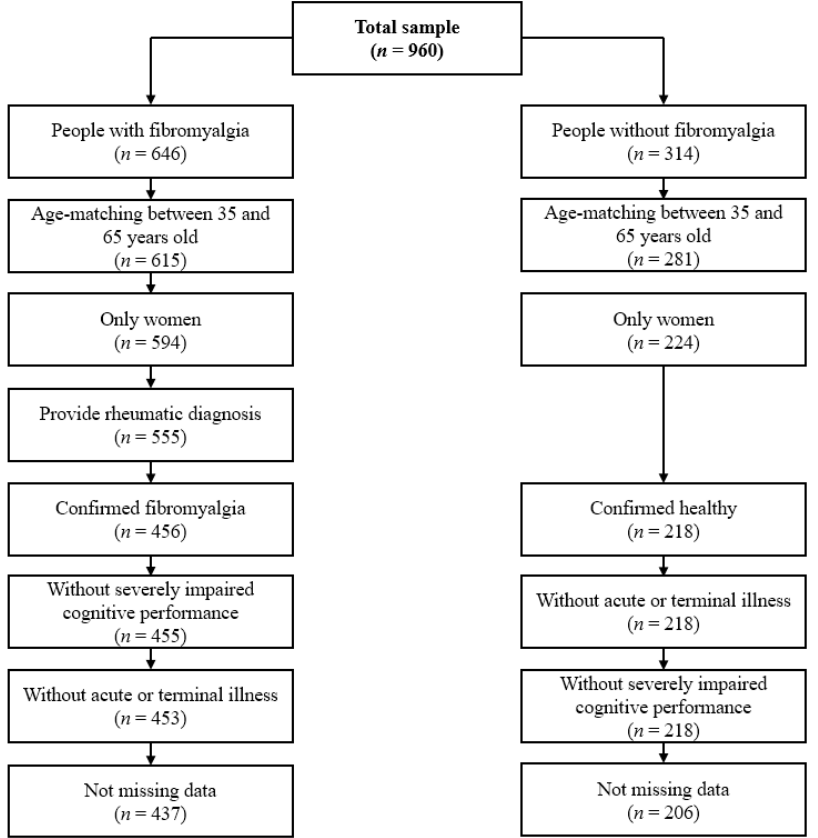
Figure 1. Flowchart of the participants . Table 1. Characteristics of the participants ( n = 643).